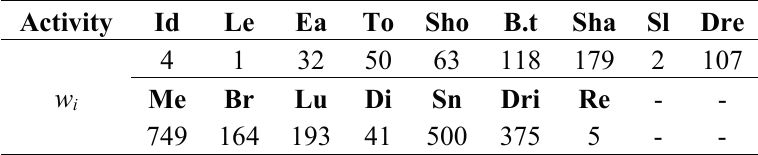
Table 4. Selection of the weights w i using TK57M